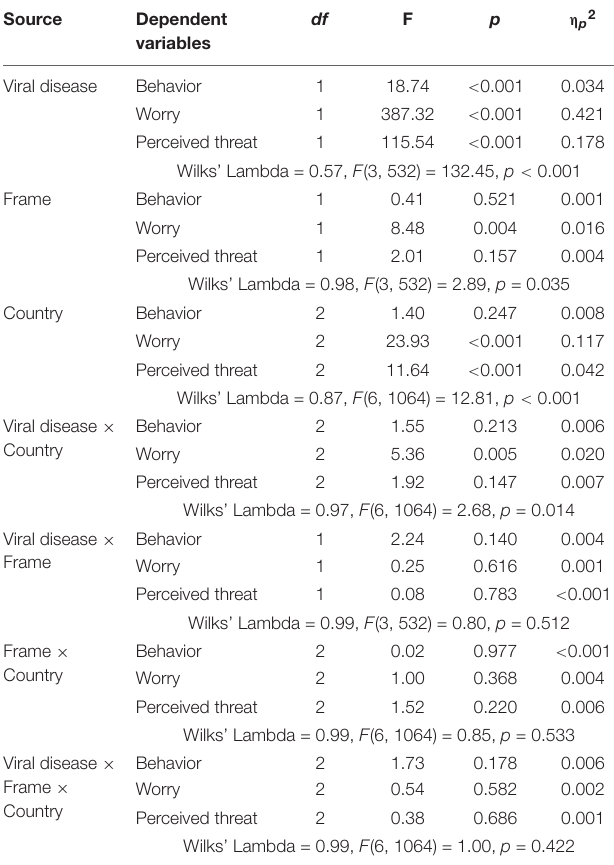
TABLE 2 | MANOVA of the effect of the manipulations on the three main dependent variables. Source